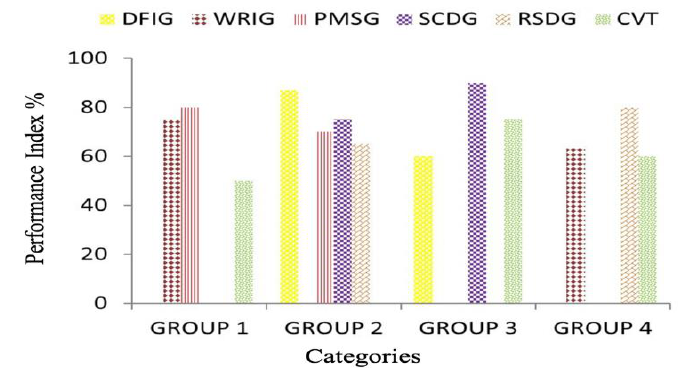
Figure 16. Performance comparison of six VSDG techniques.